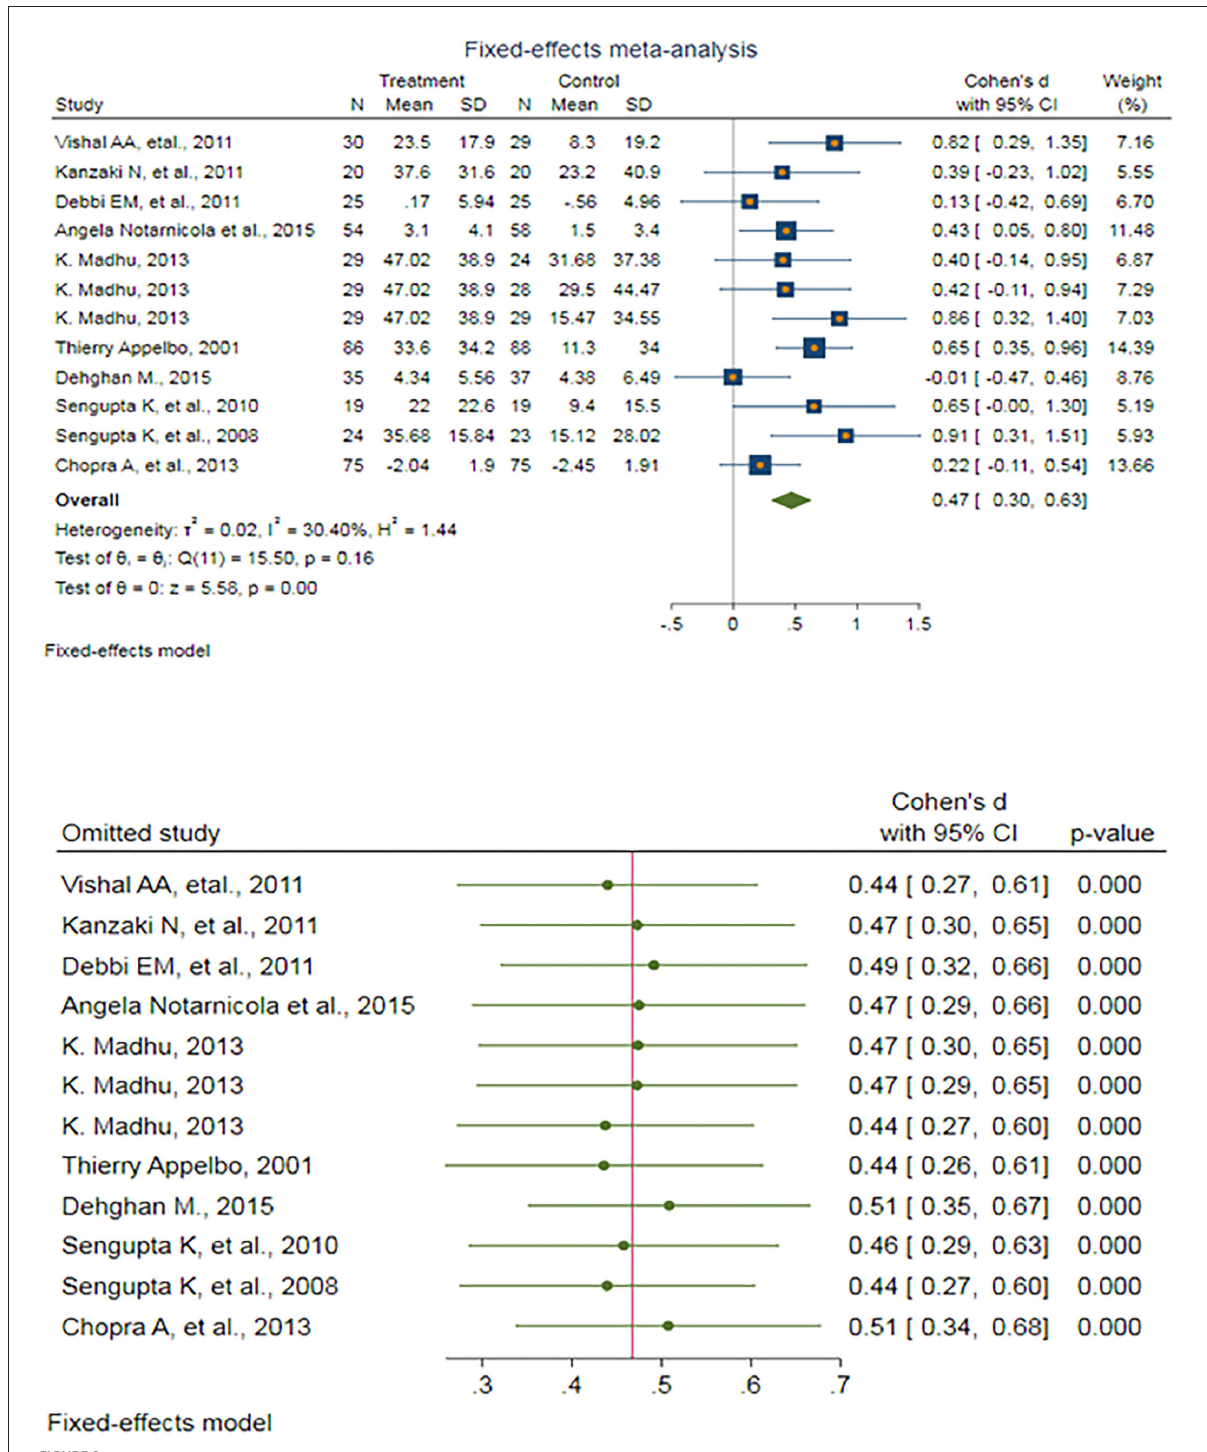
FIGURE2 (UP) A forest plot for the association between antioxidants and the outcomes of interest in osteoarthritis (OA) based on the visual analog scale (VAS). (DOWN) Forest plot of sensitivity analysis for the association between antioxidants and the outcomes of interest in OA based on the